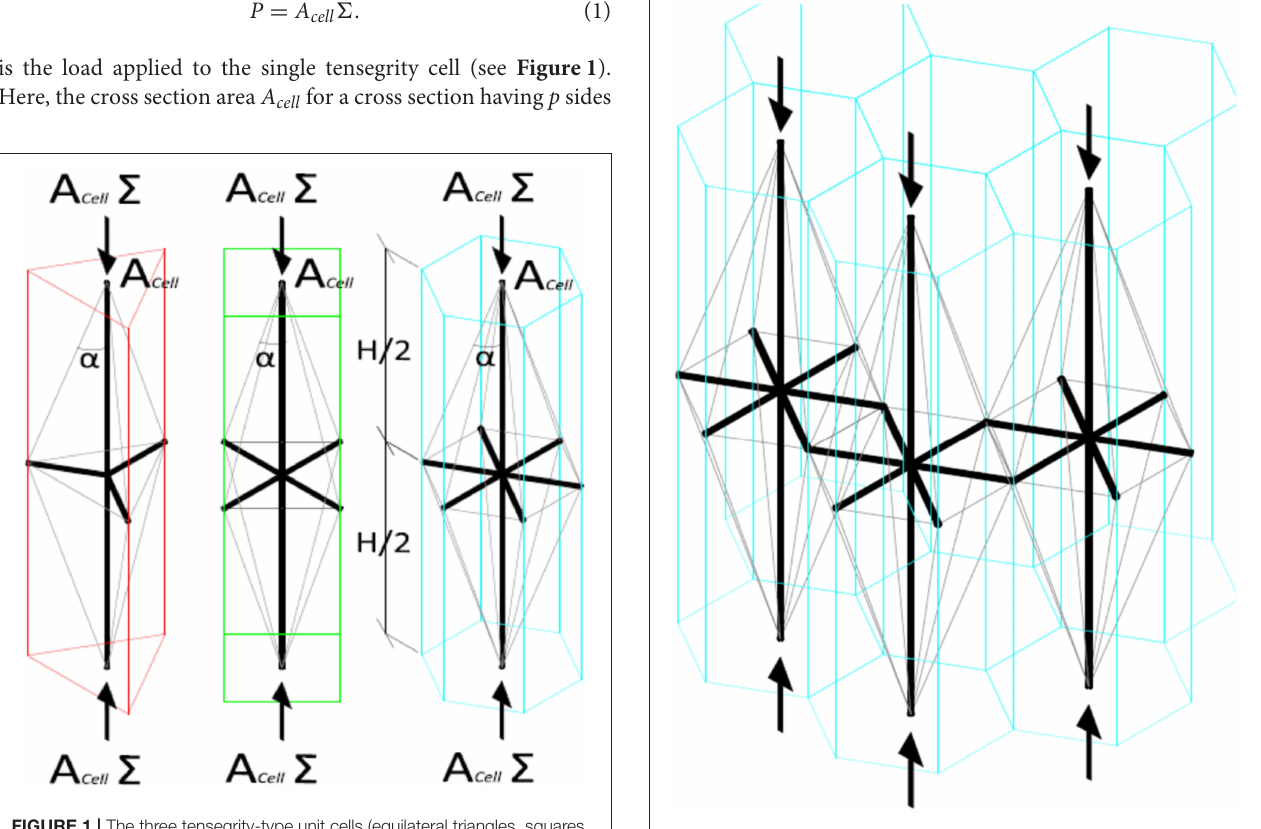
FIGURE 1 | The three tensegrity-type unit cells (equilateral triangles, squares, regular hexagons). FIGURE 2 | Scheme of the slab composed of hexagonal